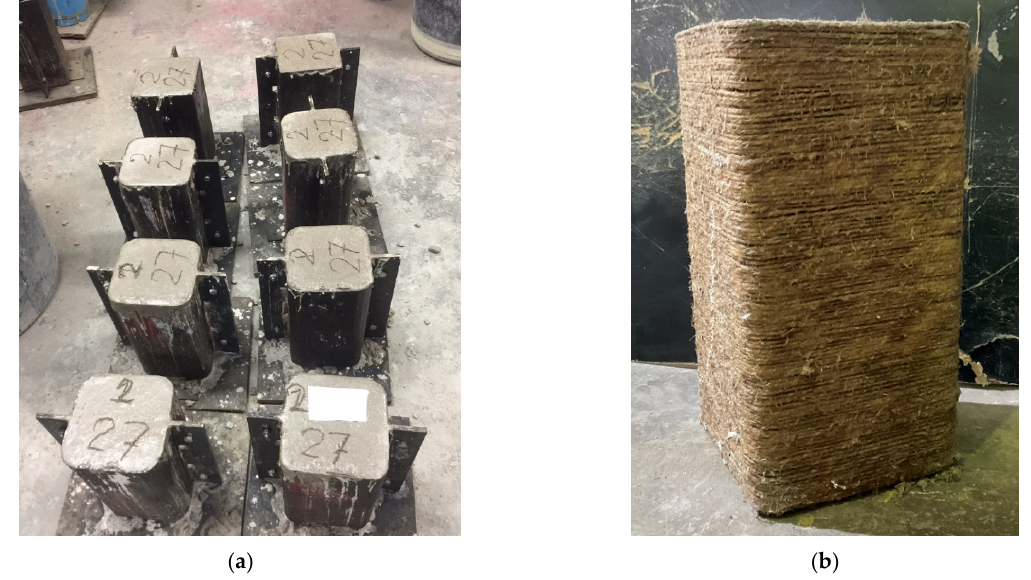
Figure 3. ( a ) LAC-filled steel molds and ( b ) a typical strengthened